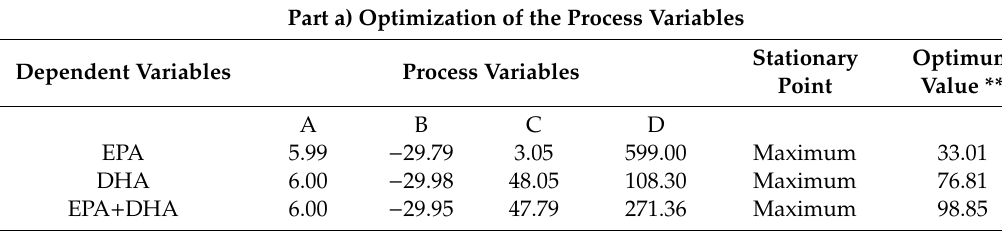
Table 3. Process variables * optimization and multiple response optimization of the response